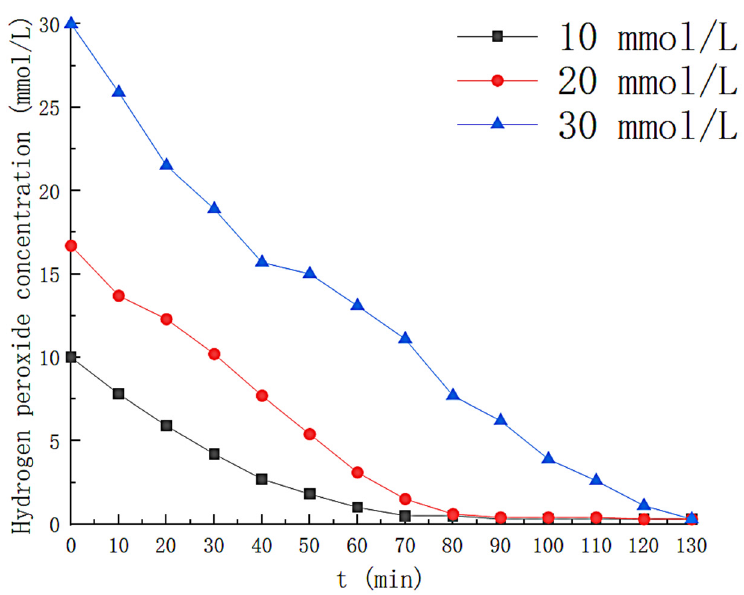
Figure 9. Change of hydrogen peroxide concentration with time.